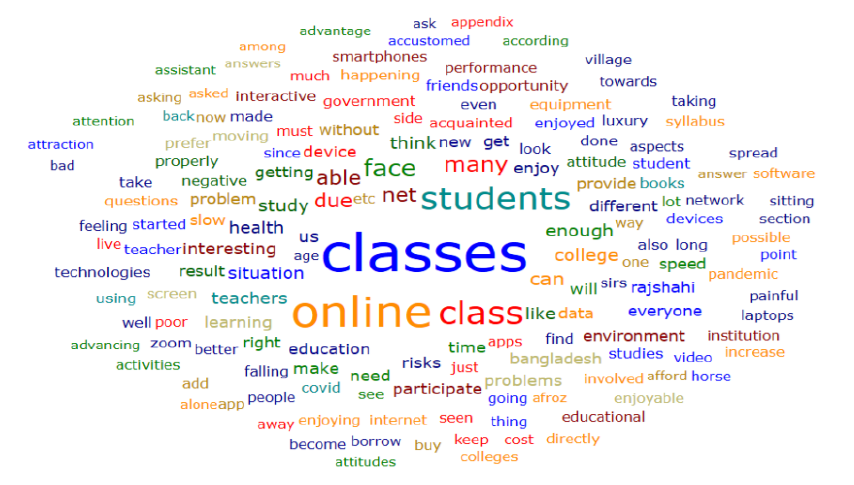
Figure 6: World Cloud Based on the FGD (student) by using Atlas-9